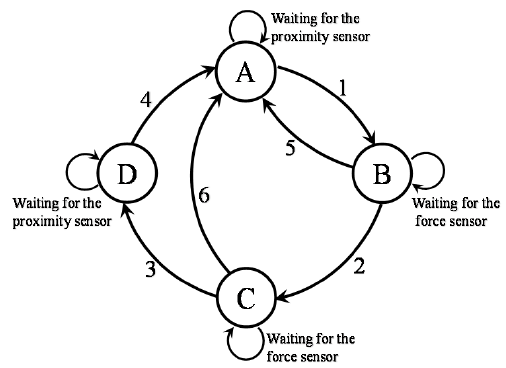
Figure 10. Diagram of the state machine (operating cycle) of the assistive system.